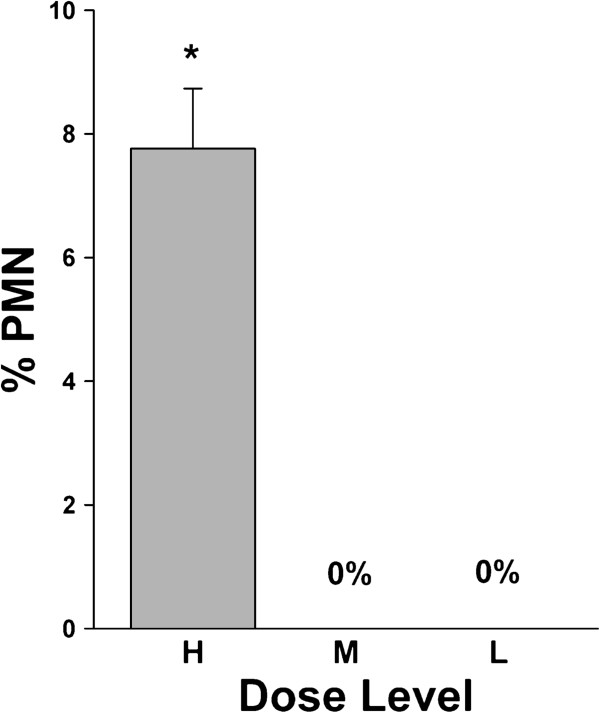
Effect of multi-walled carbon nanotube (MWCNT) inhalation on pulmonary inflammatory cell influx at 0 d post-exposure. Polymorphonuclear cells, an indication of pulmonary inflammation, were measured from reconstituted pellets of the bronchoalveolar cellular fraction. H = high dose; M = middle dose; L = low dose. Data are expressed as percent (%) PMN from a total of 300 cells counted slides from cytospins. *p<0.05 vs. respective sham.